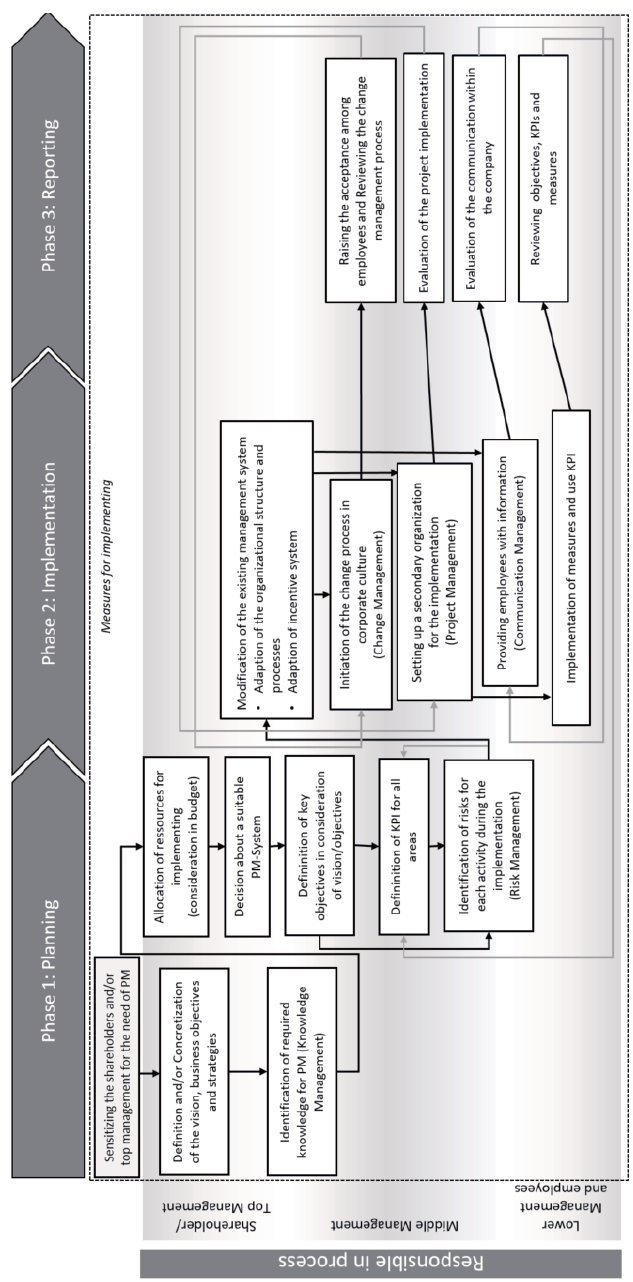
Fig. 1 – Integrated three-phase-framework for the implementation of BPM. Source: own research